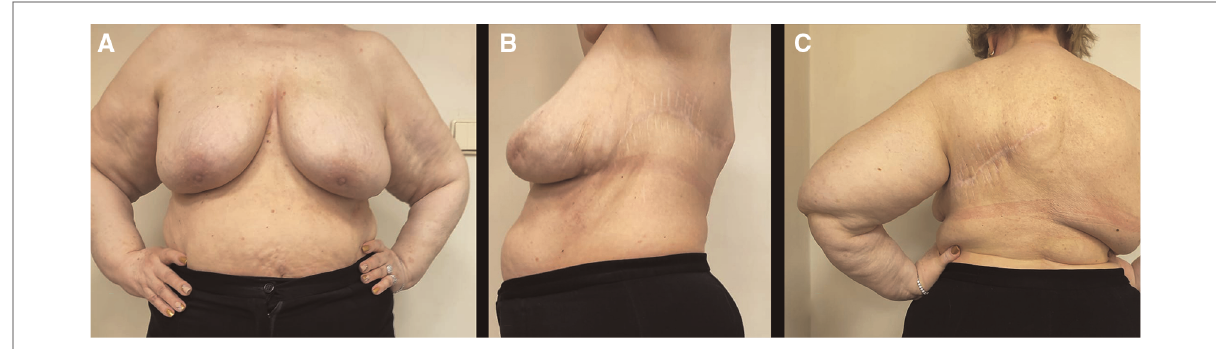
FIGURE 4 Four-year follow-up outcomes after surgical and radiation therapy. ( A ). Front view (Mammary glands are positioned at the same level). ( B ). Lateral view. ( С ). Back